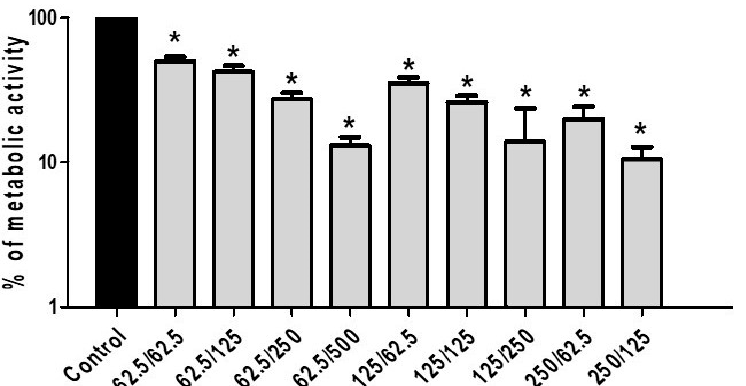
Figure 5. Biofilm formation capability recorded by different combinations of CA and PP in C. albicans SC5314 strain. The metabolic activity of the formed biofilms was quantified by the XTT reduction assay (see Methods). The results are expressed as the mean + standard deviation of two experiments with six replications for each group. The concentrations of CA and PP are expressed as µg/mL.